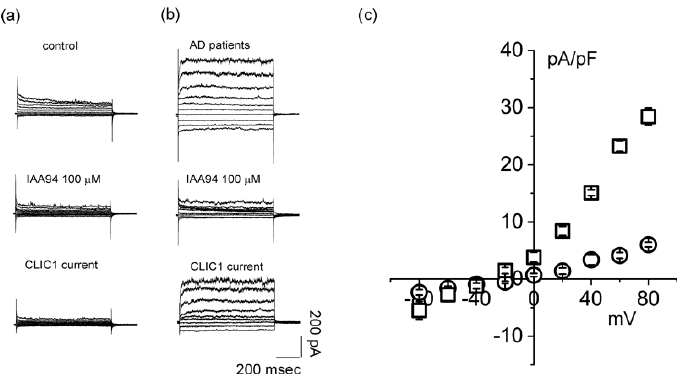
Figure 5. Electrophysiology measurements of isolated monocytes. Perforated patch-clamp recordings of membrane currents elicited by 800 msec voltage steps from − 80 to + 80 mV every 20 mV in control cells ( a ) and monocytes from AD patients ( b ). CLIC1 currents (bottom traces) have been isolated subtracting IAA94 100 µ M sensitive current from total currents. ( c ) Current / voltage relationship of CLIC1 membrane current density in monocytes from AD patients ( n = 6, open squares) and from control individuals ( n = 5, open circles). Statistics analysis: unpaired t -test (*, p = 0.0137 at 0 mV; ****, p < 0.0001 at +20, +40, +60 and +80 mV).